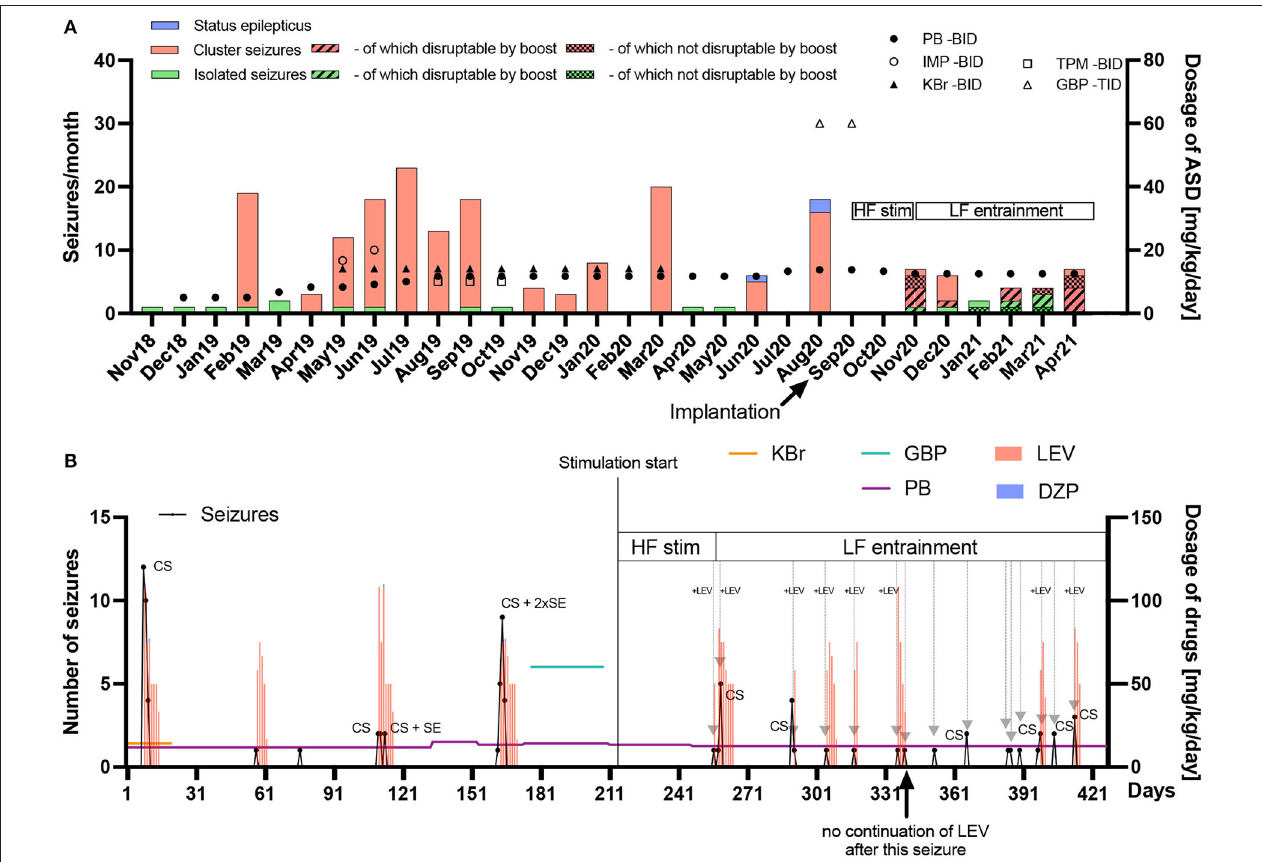
FIGURE 4 | Frequency and chronic/acute pharmacological treatment of seizures until seven months after implantation. (A) The seizure frequency (left y-axis) and average daily antiseizure drug (ASD) dosage in mg/kg/day (right y-axis) of phenobarbital (PB), imepitoin (IMP), potassium bromide (KBr), topiramate (TPM) and gabapentin (GBP) twice (BID) or thrice (TID) daily are shown for every month since epilepsy onset in November 2018. When stimulation was started, no further status epilepticus (SE) occurred. After implantation, high frequency (HF) stimulation was applied after seizures occurred in order to prevent SE or further cluster